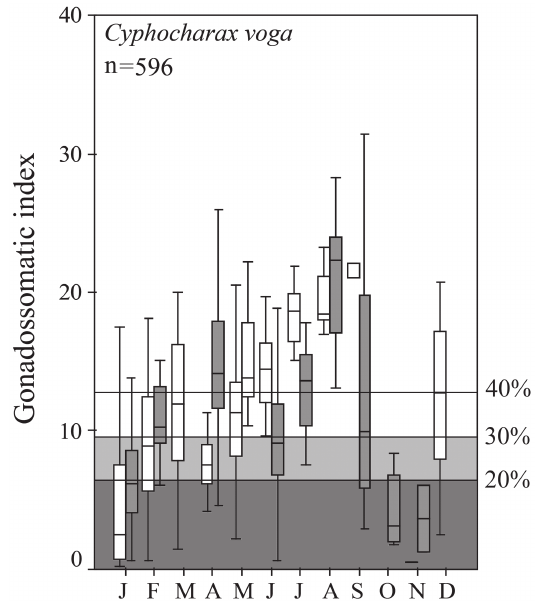
Fig. 3. Monthly variation of Cyphocharax voga GSI values Fig. 5. Monthly variation of Oligosarcus jenynsii GSI values (adult females only) in Guaíba Lake (white) and Casamento (adult females only) in Guaíba Lake (white) and Casamento Lake (dark gray), Rio Grande do Sul, Brazil (median, 25- Lake (dark gray), Rio Grande do Sul, Brazil (median, 25- 75% quartiles and lower-upper GSI limits by month and 75% quartiles and lower-upper GSI limits by month and site). Three GSI cut-off values were tested with respect to the site). Three GSI cut-off values were tested with respect to the maximum GSI recorded for each species, for delimitation of maximum GSI recorded for each species, for delimitation of reproductive months: 20% (G ), 30% (G ) and 40% (G ). reproductive months: 20% (G ), 30% (G ) and 40% (G 20 30 40 20 30 40